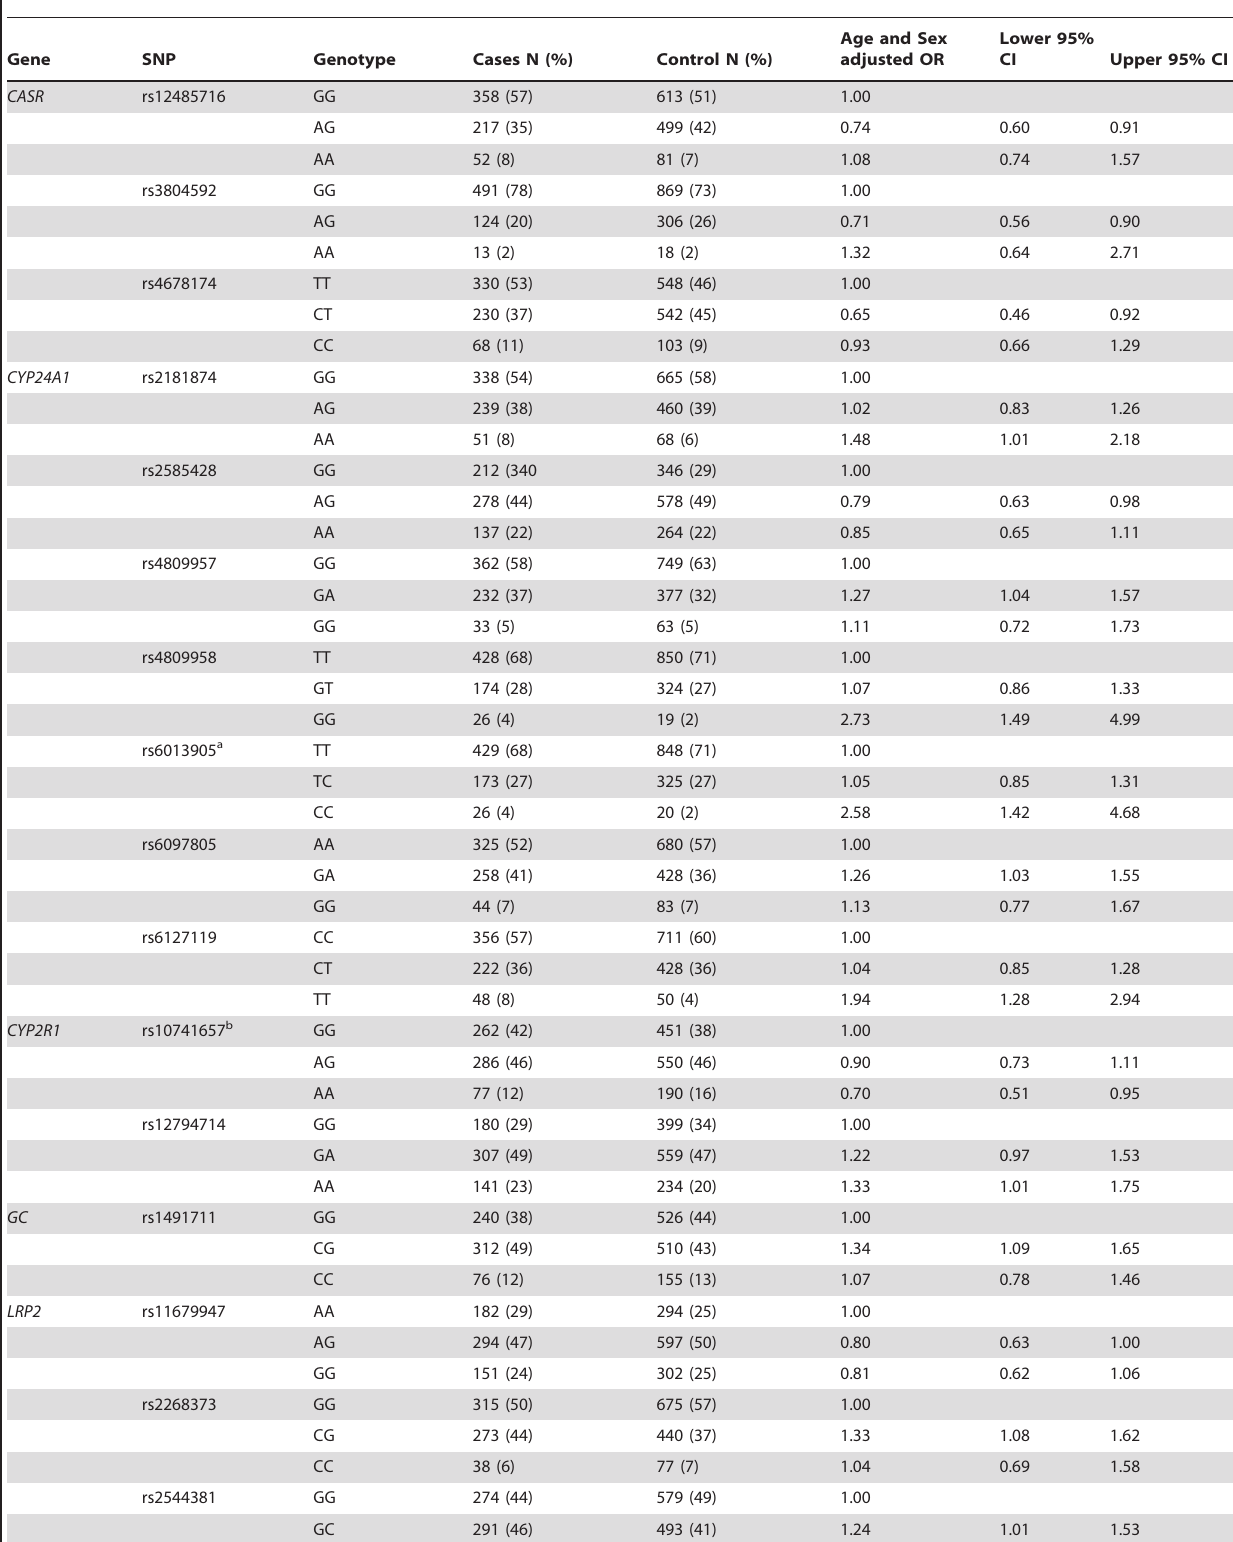
Table 4. Age and sex adjusted odds ratios for the associations between SNPs in vitamin D-related genes and pancreas cancer risk among Ontario cases (n=628) and controls (n=1193) by genotype categories; results are shown for all SNPs with 95% confidence intervals that do not overlap